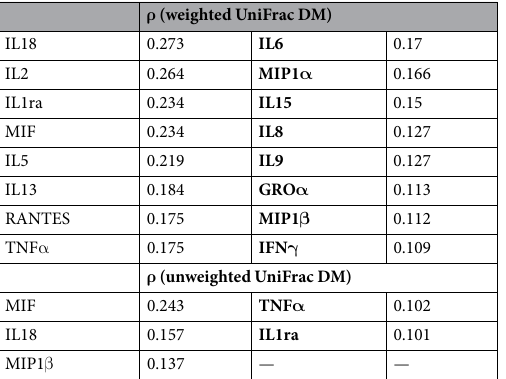
Table 4. Output of the BIOENV rank-correlation procedure. Correlations between the 48 immune mediators and both weighted and unweighted UniFrac distance matrices are shown. The table shows the results for ρ ≥ 0.1. The results were generated from the beta_diversity.py output using the compare_categories.py script (metric BIOENV) of QIIME. Abbreviations: ρ : Spearman’s rank correlation coefficient; DM: distance